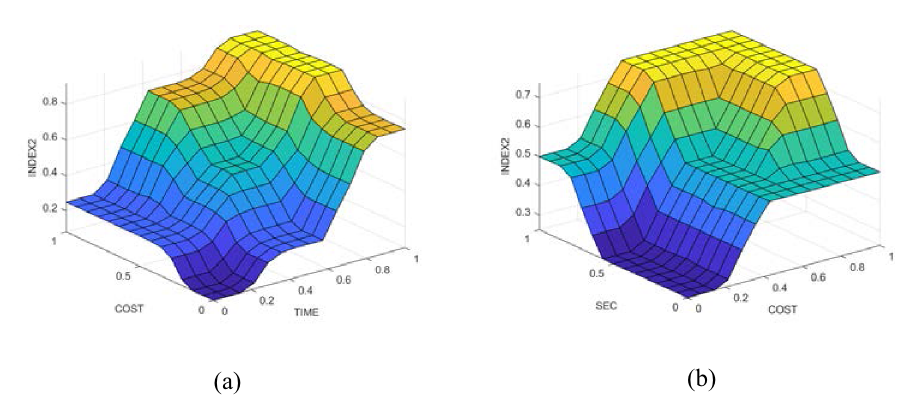
Fig. 6. Non-critical Variable Surface Plot.